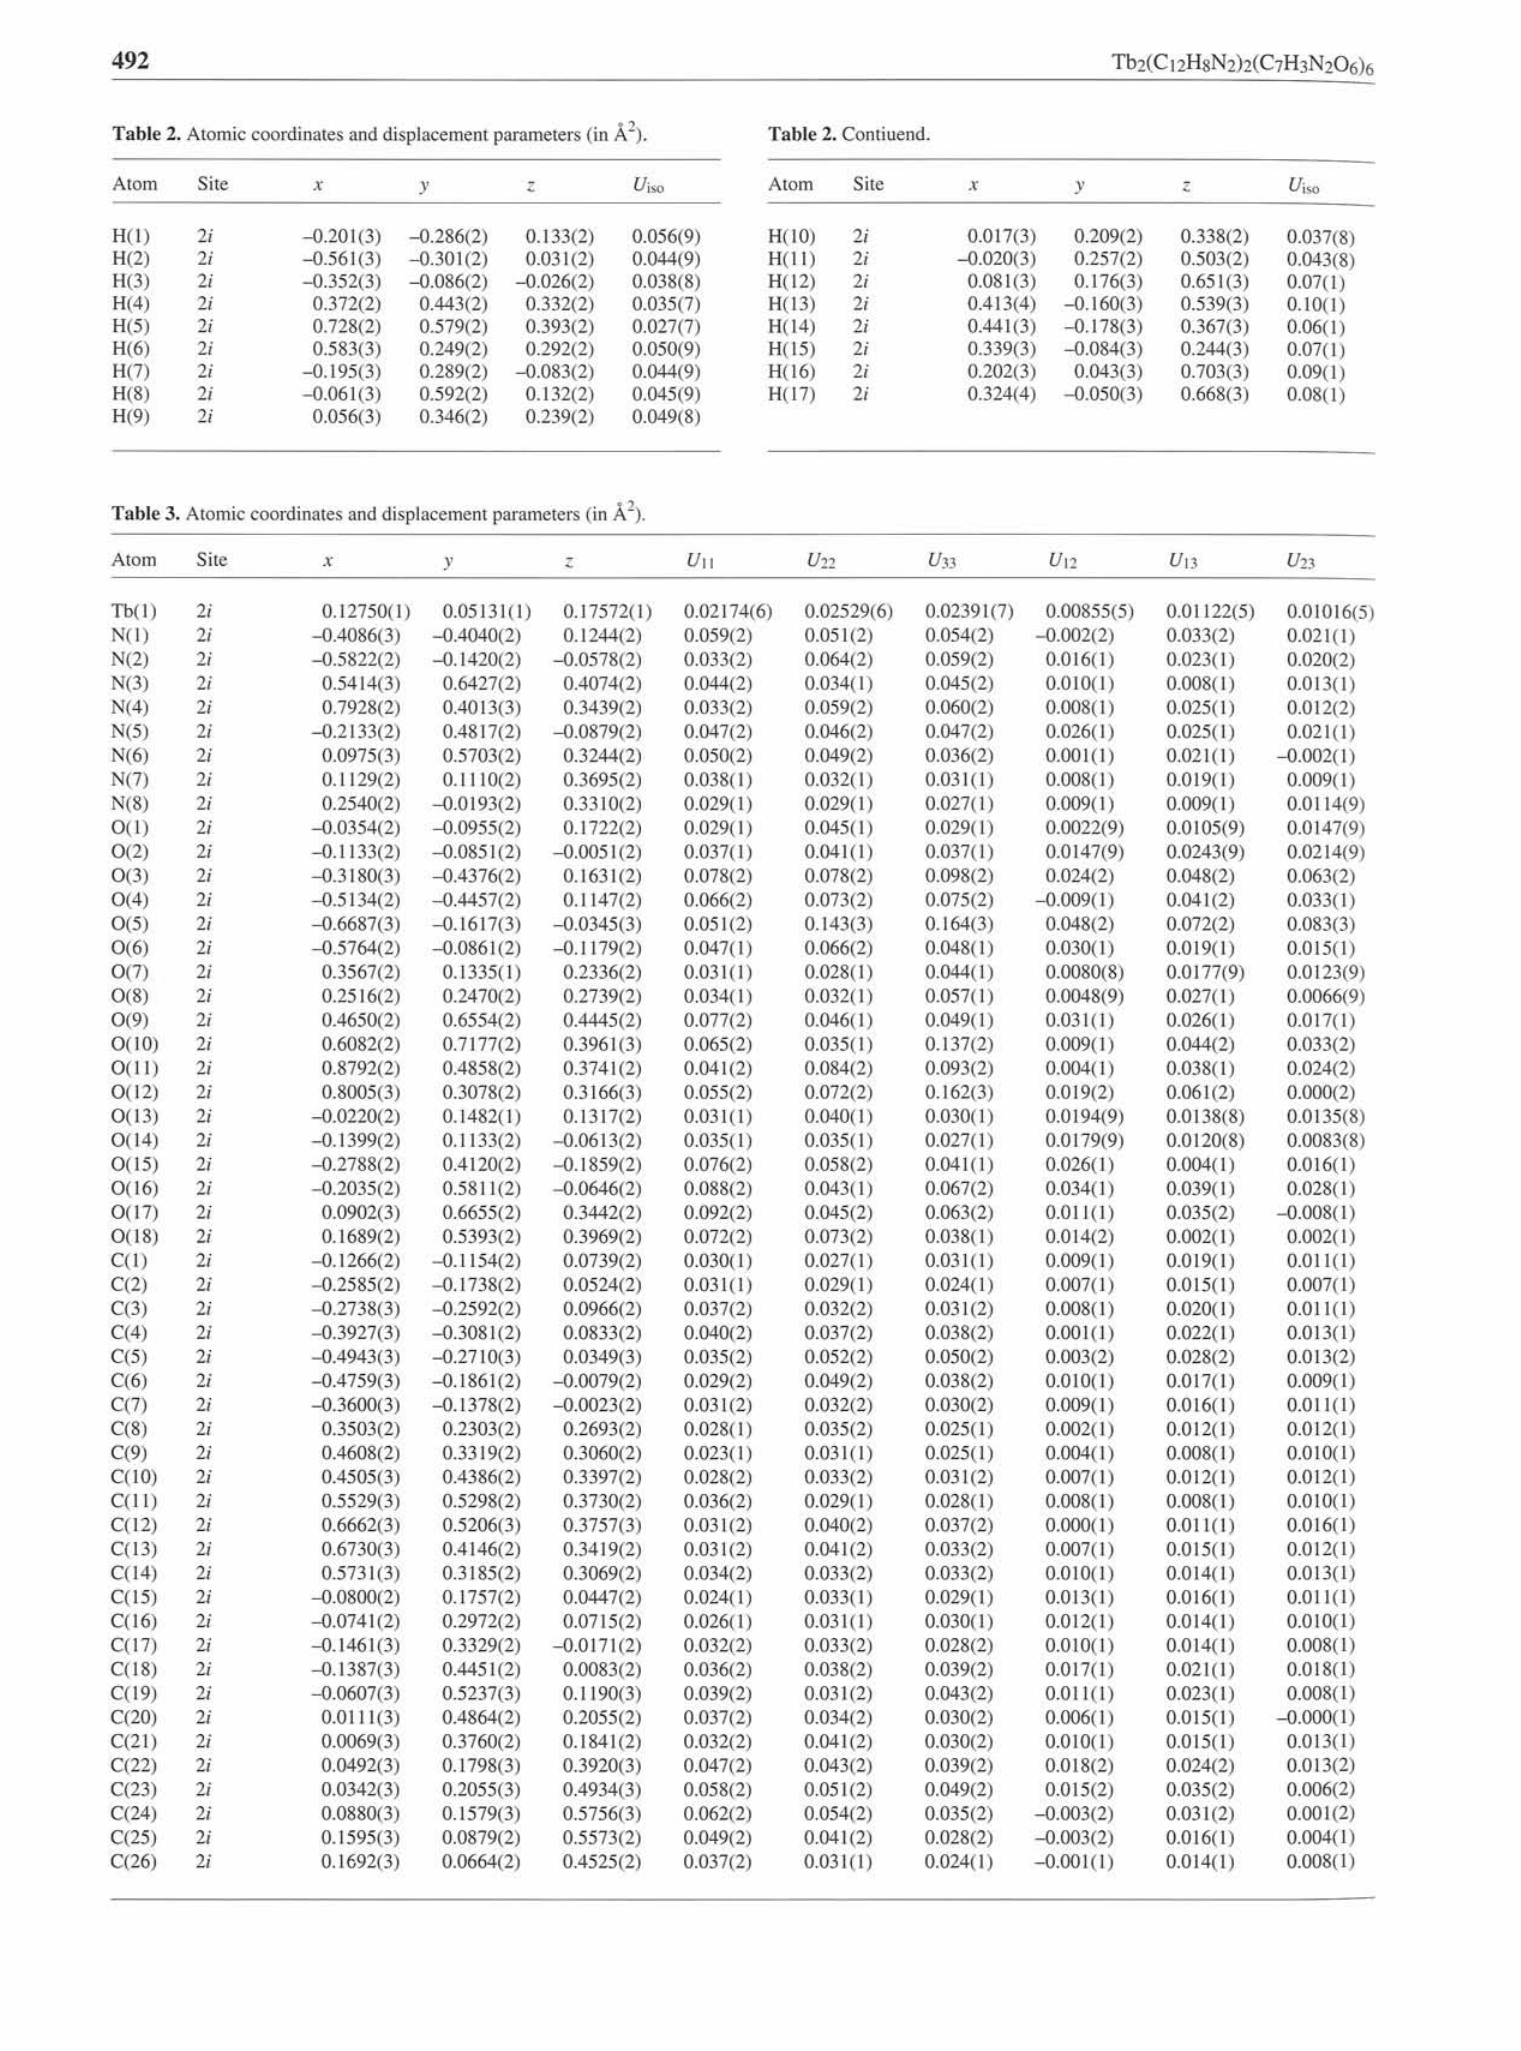
Table 2. Atomic coordinates and displacement parameters (in A"). Table 2. Contiuend.